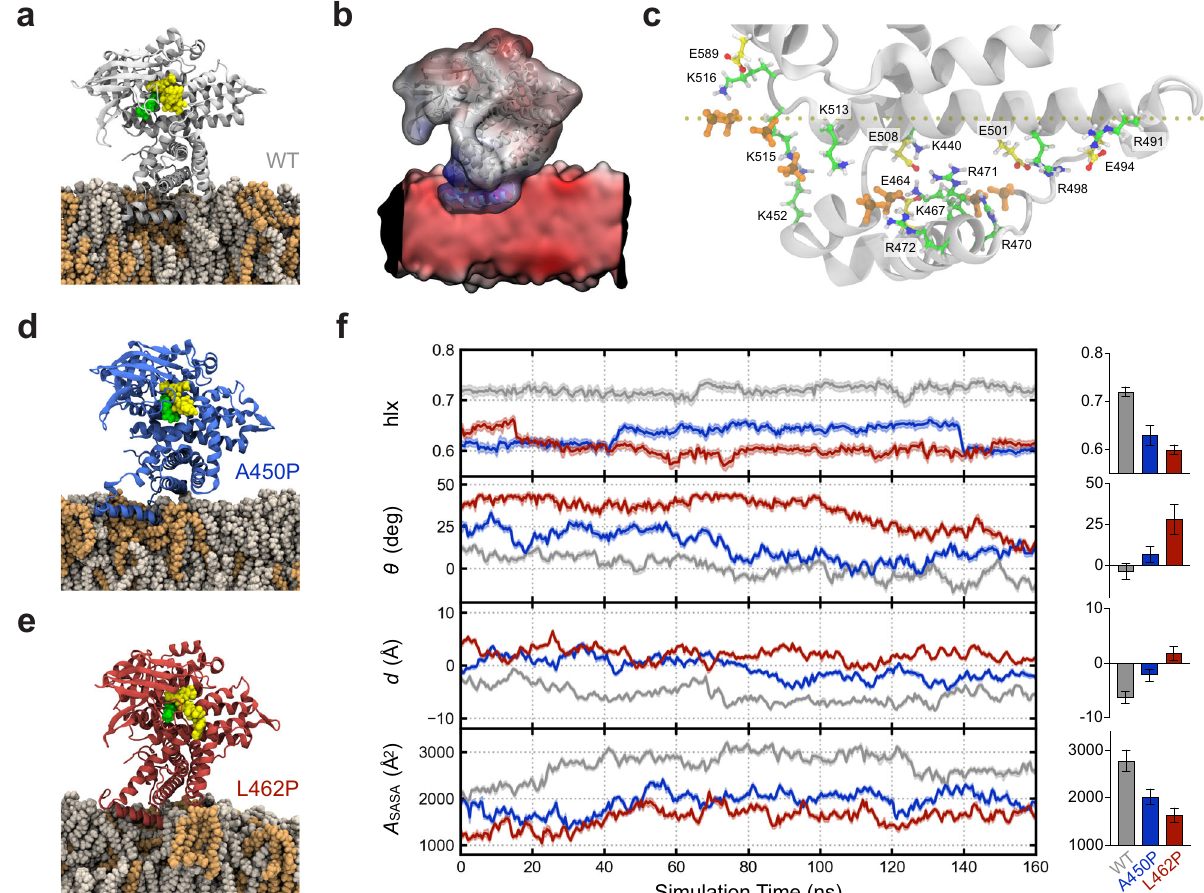
Fig. 5 Molecular dynamics simulations of VLCAD and its proline mutants in the presence of membrane. a Simulated structure of a wild-type VLCAD monomer in contact with a cardiolipin-containing membrane bilayer (4:1 ratio of phosphatidylcholine [POPC]: tetraoleoyl cardiolipin [TOCL]), as demonstrated by molecular dynamics simulation after 125 ns of equilibration. Residues 446 – 474 of the α -helical hairpin insert deeply and stably into the lipid membrane. POPC, tan; TOCL, orange; FAD, yellow; substrate, green. b Independently computed electrostatic maps for wild-type VLCAD and lipid membrane, illustrating a complementary potential V between adjacent regions (blue: V > 0; red: V < 0; white, V = 0). c Representative electrostatic interactions between cationic (K, R) residues of VLCAD and cardiolipin headgroups of the lipid membrane or anionic (D, E) amino acids of the protein. To maintain clarity, only the charged phosphates (PO 4 2 − ) of TOCL (orange) are shown. d , e Proline mutagenesis disrupts the local structure, resulting in more super fi cial membrane interaction compared to wild-type VLCAD, as demonstrated by molecular dynamics simulation of the A450P and L462P variants after 125 ns of equilibration. f Comparative geometric quanti fi cation of the membrane interactions of wild-type and proline-mutant VLCAD proteins, including, from top to bottom, (1) helical content hlx of the C-terminal region comprised of amino acids 436 – 488, (2) instantaneous tilt angle θ between a membrane-embedded α -helical segment (residues 460 – 474) and the membrane surface, (3) height d of the helix center-of-mass with respect to the membrane surface, as de fi ned by a plane through phosphate atoms in the proximal membrane lea fl et, whereby values with d < 0 lie below the lipid headgroups, and (4) solvent-accessible surface area A SASA buried at the VLCAD-lipid interface. Trajectories were smoothed by averaging over 0.5 ns bins, and bands re fl ect the standard deviation within these bins. Calculations were facilitated by the collective variables module of VMD 71 where applicable 72 . Adjacent bar graphs depict mean values ± s.d. of the geometric parameters, calculated over the last 80 ns equilibration trajectory ( n =